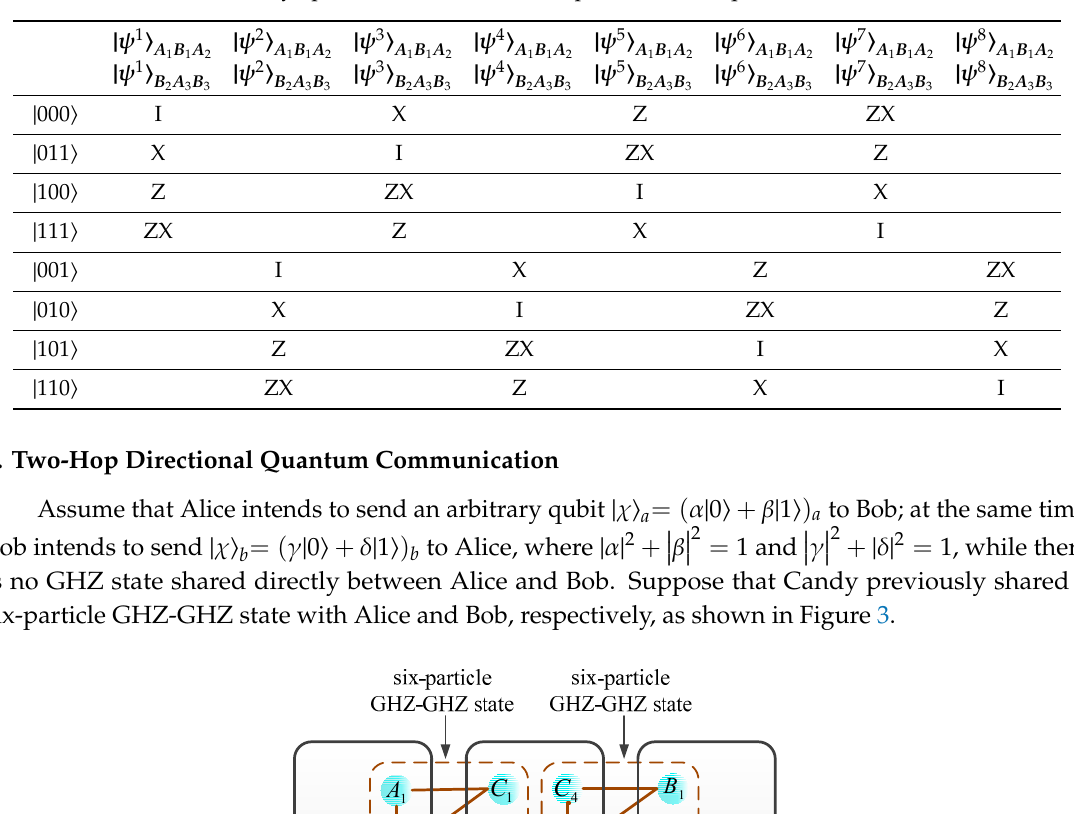
Table 2. The unitary operations to realize one-hop bidirectional quantum communication.